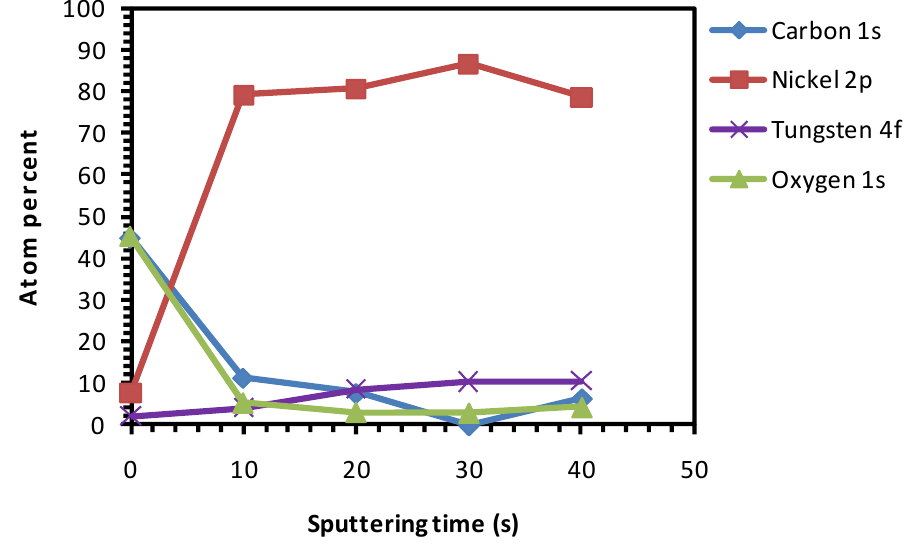
Figure 12. XPS depth profile studies of Ni-5% W substrate after chemical cleaning with etching for 15 min followed by thermal cleaning.